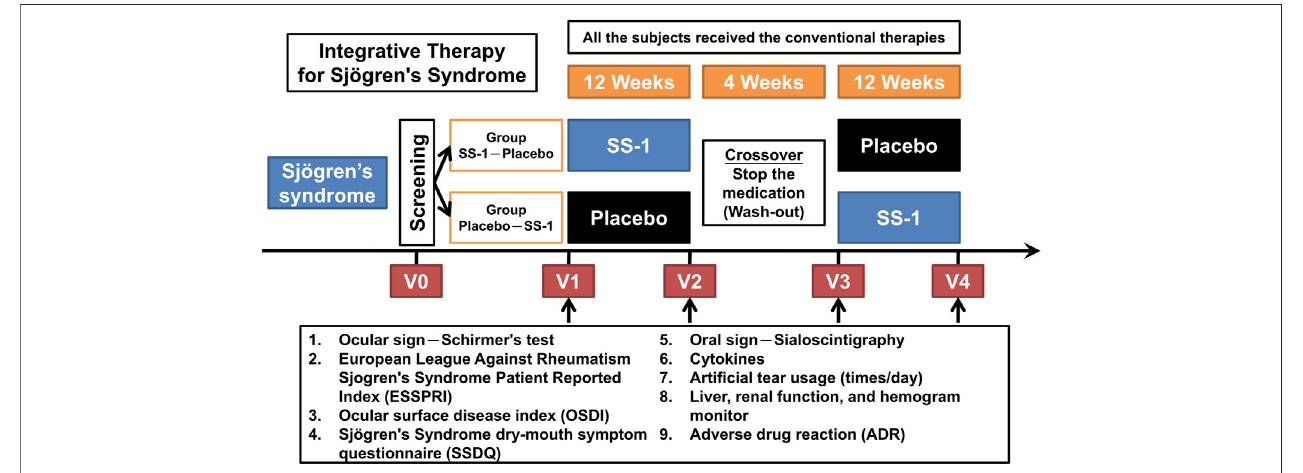
FIGURE 1 | The protocol for this integrated clinical trial. The recruited patients were randomly divided into two groups of “ Group SS-1-Placebo ” and “ Group Placebo-SS-1. ” SS-1wasadministeredinanadd-ondesign,andallthesubject ’ sstillrequiredthesameHCQtreatmentthroughoutthetrial.Bothgroupsdidnotreceive additionalpilocarpineorcevimeline,whichwereadministered inthepatient ’ srespectiverheumatology OPDs.The “ GroupSS-1-Placebo ” patients fi rstreceivedSS-1for 12 weeks, after which they underwent a 4-weeks washout period, followed by placebo treatment for 12 weeks; and vice versa for the “ Group Placebo-SS-1 ”